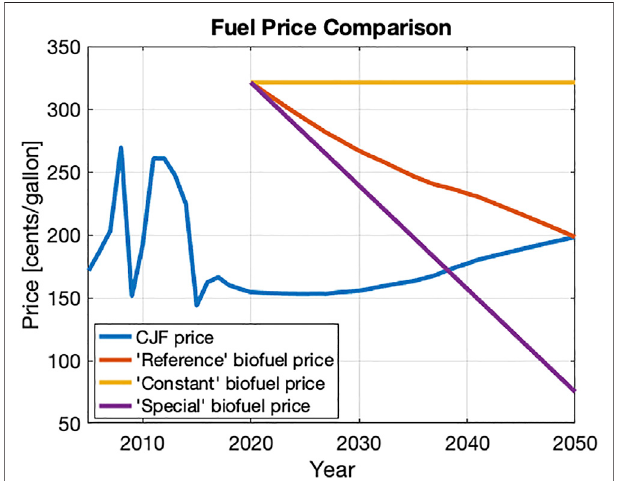
FIGURE 3 | Comparison of Conventional Jet Fuel (CJF) price in FLEET with “ Reference, ” “ Constant, ” and “ Special ” biofuel price (in 2005 U.S. Dollars).